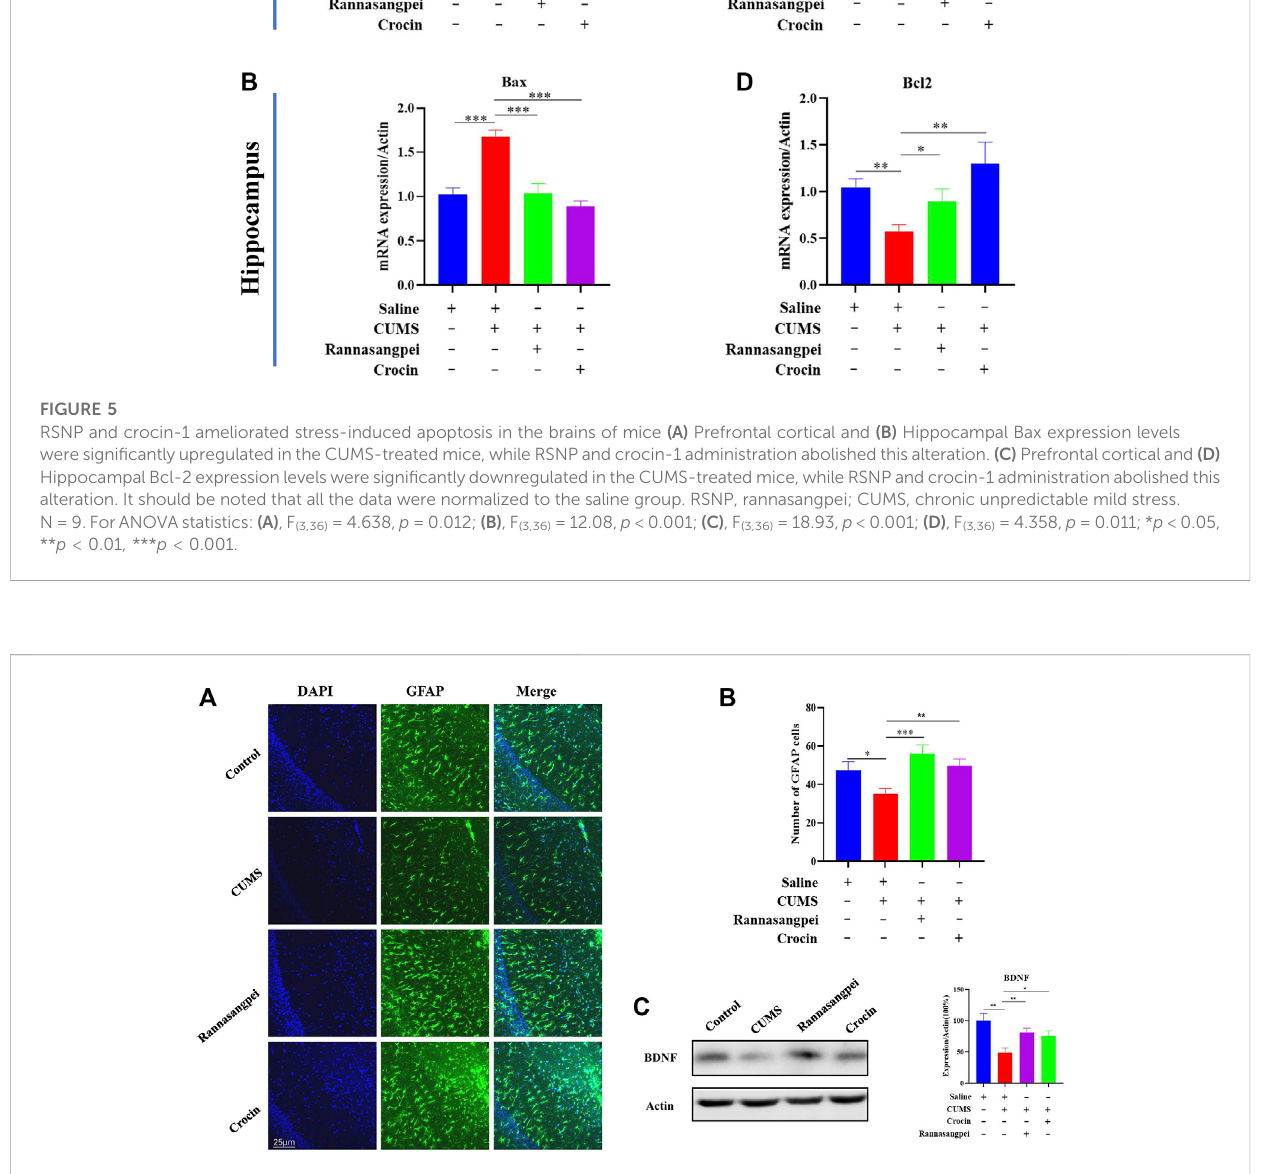
FIGURE 6 RSNP and crocin-1 increased astrocyte proliferation and BDNF expression in the hippocampus of CUMS-treated mice (A) Representative images of GFAP positive cells in the CA1 region of mice under various treatments. (B) Quanti fi cation of GFAP positive cells in the CA1 region of mice under various treatments. (C) RSNP or crocin-1 treatment signi fi cantly increased BDNF protein levels in the hippocampus of CUMS model mice. RSNP, rannasangpei; CUMS, chronic unpredictable mild stress; BDNF, brain-derived neurotrophic factor; GFAP, glial fi brillary acidic protein; N = 6. For ANOVA statistics: (B) , F (3,24) = 5.610, p = 0.0034; (C) , F (3,24) = 5.969, p = 0.0024. * p < 0.05, ** p < 0.01, *** p <